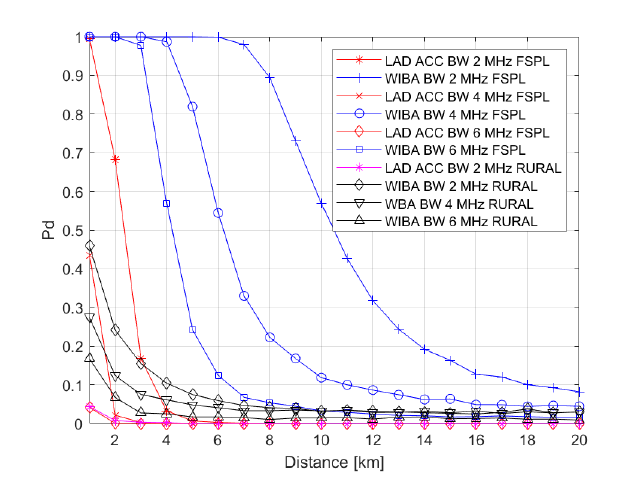
Figure 13. P vs. detection distance when transmit power of the d signal is 10 dBm. FSPL and rural